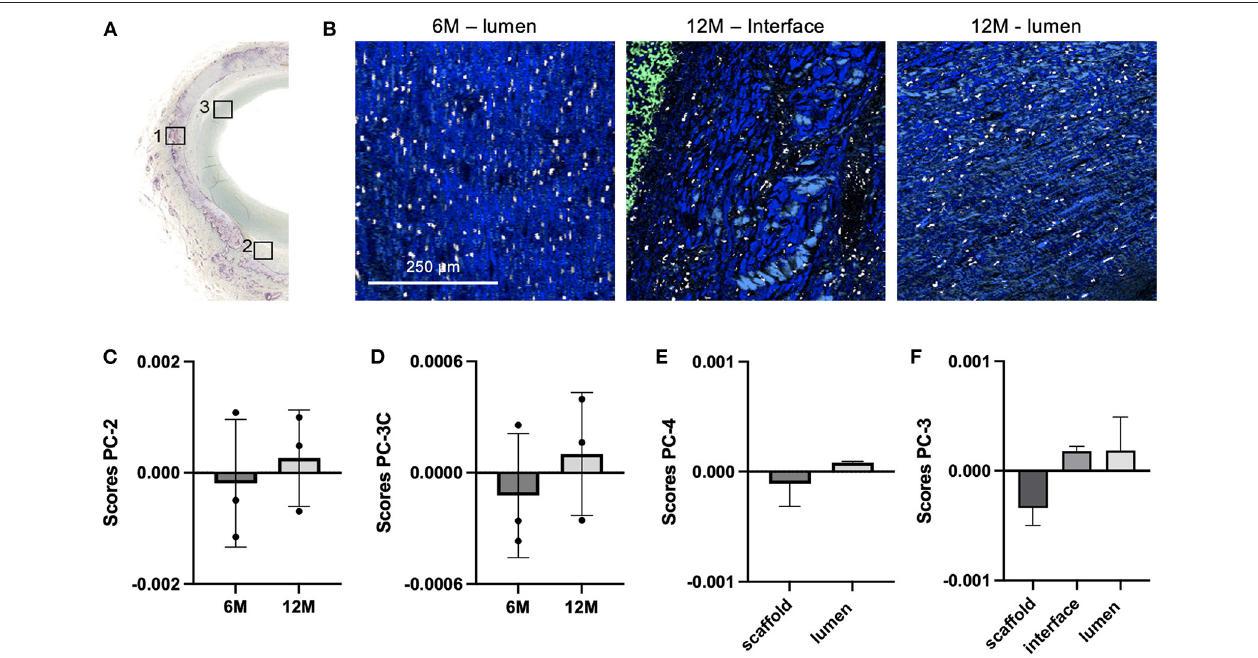
FIGURE 6 | Tissue maturation and collagen infiltration in carotid grafts. (A) Raman images were acquired from additional regions at the explant lumen (ROI3) and the interface (ROI2, only in 12-month samples), as defined in consecutive sections stained for Movat Pentachrome. (B) TCA intensity distribution heatmaps including collagen (blue), PC-UPy (light green) and cells (white) signatures; scale bar equals 250 µ m. Extracted collagen spectra were compared by PCA for (C) 6 vs. 12-month scaffold region (ROI1), (D) 6 vs. 12-month luminal region (ROI3), (E) scaffold vs. luminal region in 6-month samples and (F) scaffold vs. interface vs. luminal region in 12-month samples; data are represented as mean score values ± SD, n =